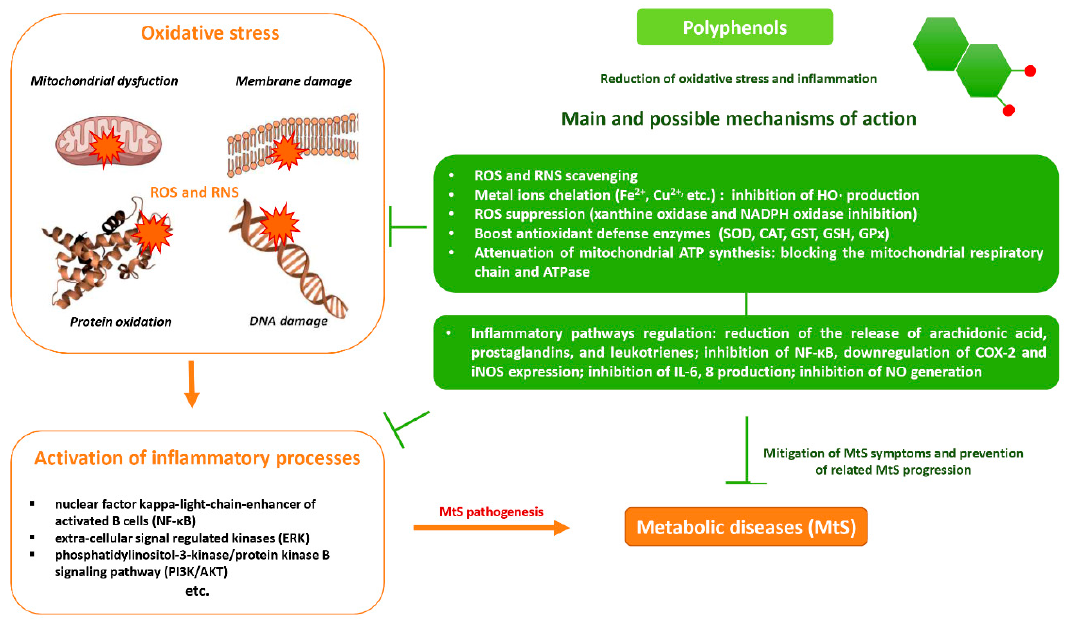
Figure 3. Overall mechanisms of action of PPs against oxidative stress and inflammation leading to MtS.